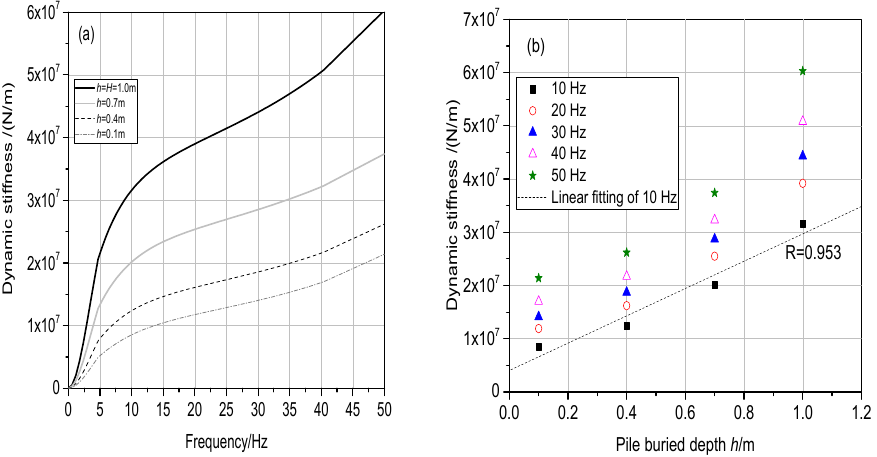
Figure 16. Dynamic stiffness changes for various pile buried depths for model P3: ( a ) K d ( f ) function; and ( b ) K d values at 10, 20, 30, 40, and 50 Hz.